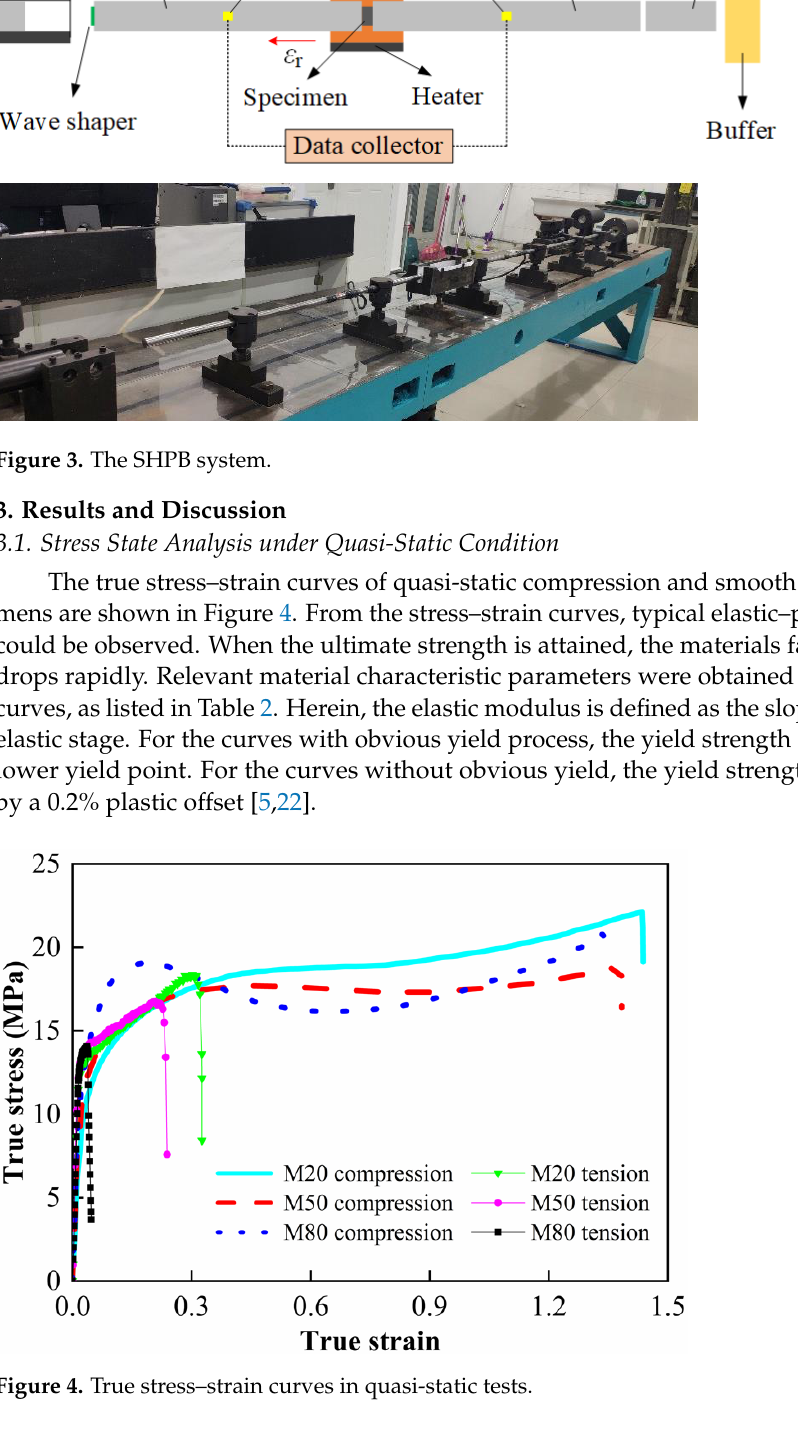
Figure 4. True stress–strain curves in quasi-static tests.